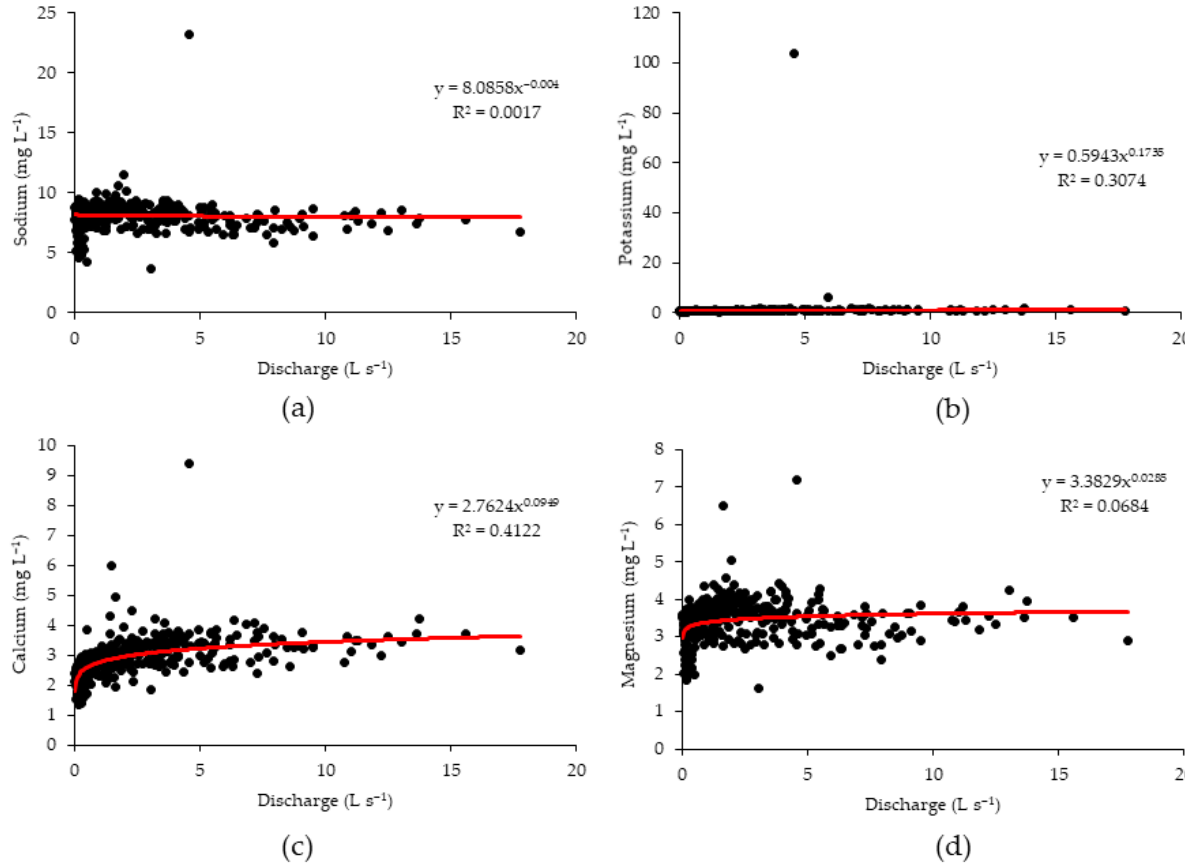
Figure 9. Concentration-discharge relationships for ( a ) sodium, ( b ) potassium, ( c ) calcium and ( d ) magnesium in the Abelar catchment. Regression equations and coefficients are shown.